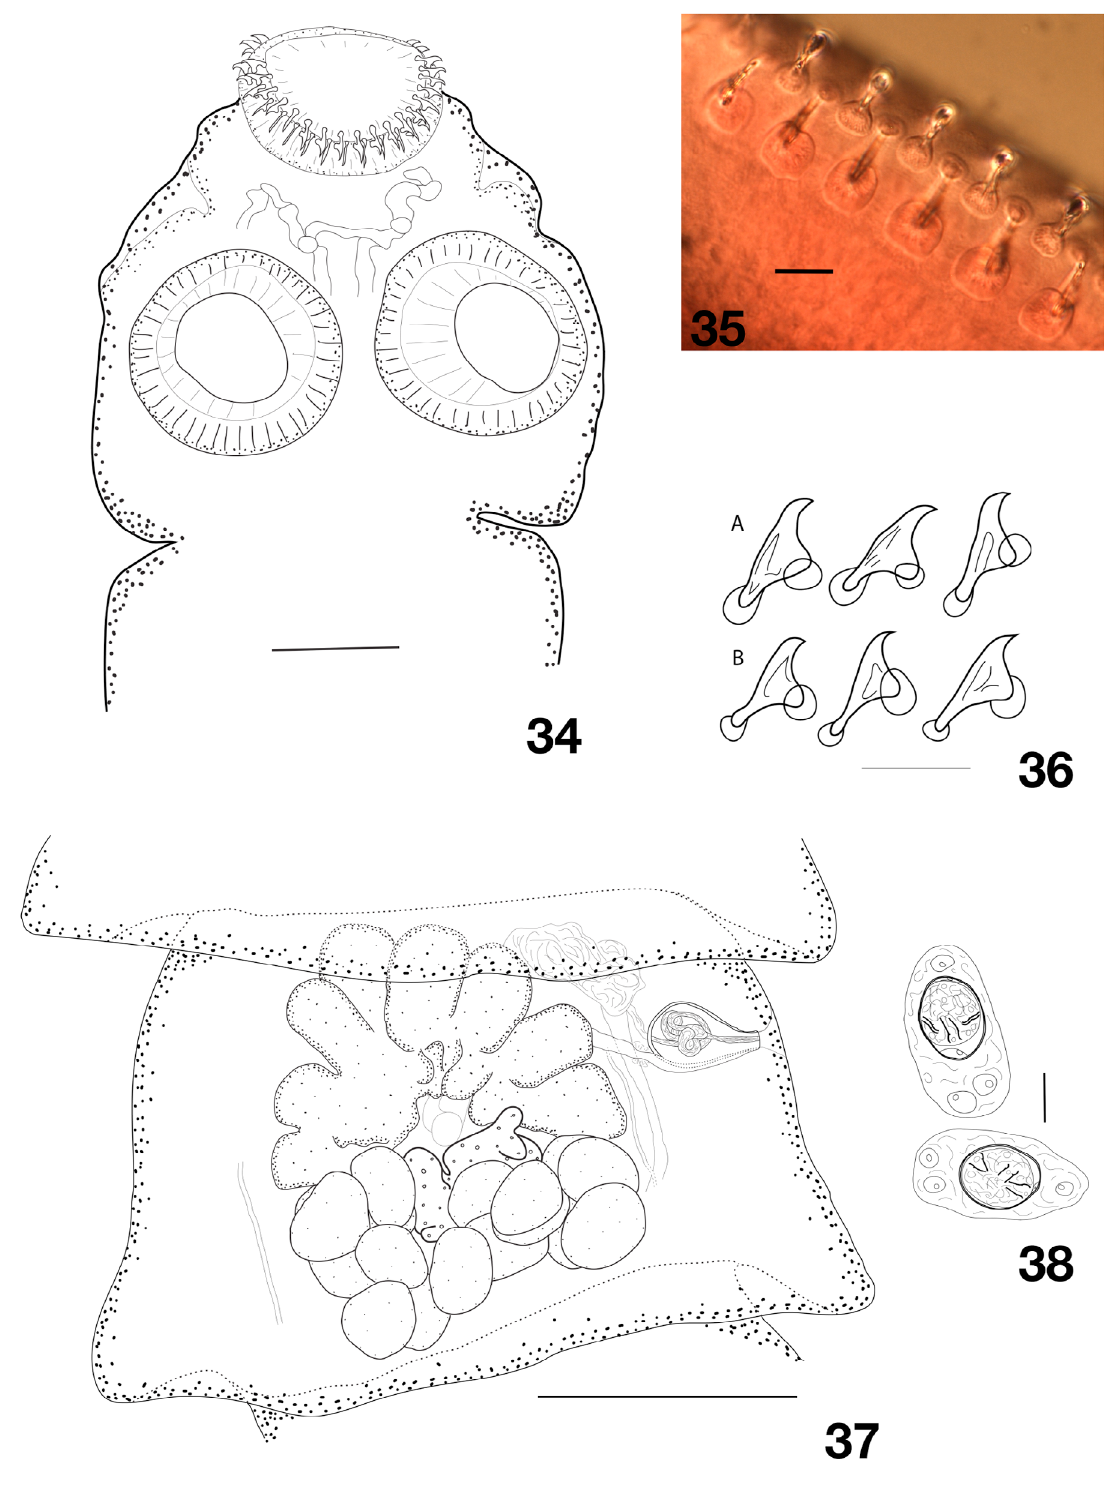
Figs 34–38. Cracticotaenia adelaidae sp. nov. 34 . Scolex. 35 . Detail of hooks crowns. 36 . Hooks: anterior (A) and posterior (B). 37 . Mature proglottis. 38 . Eggs. Scale bars: 34 = 100 µm; 35 = 10 µm; 19 = 500 µm; 36, 38 = 20 µm; 37 = 250